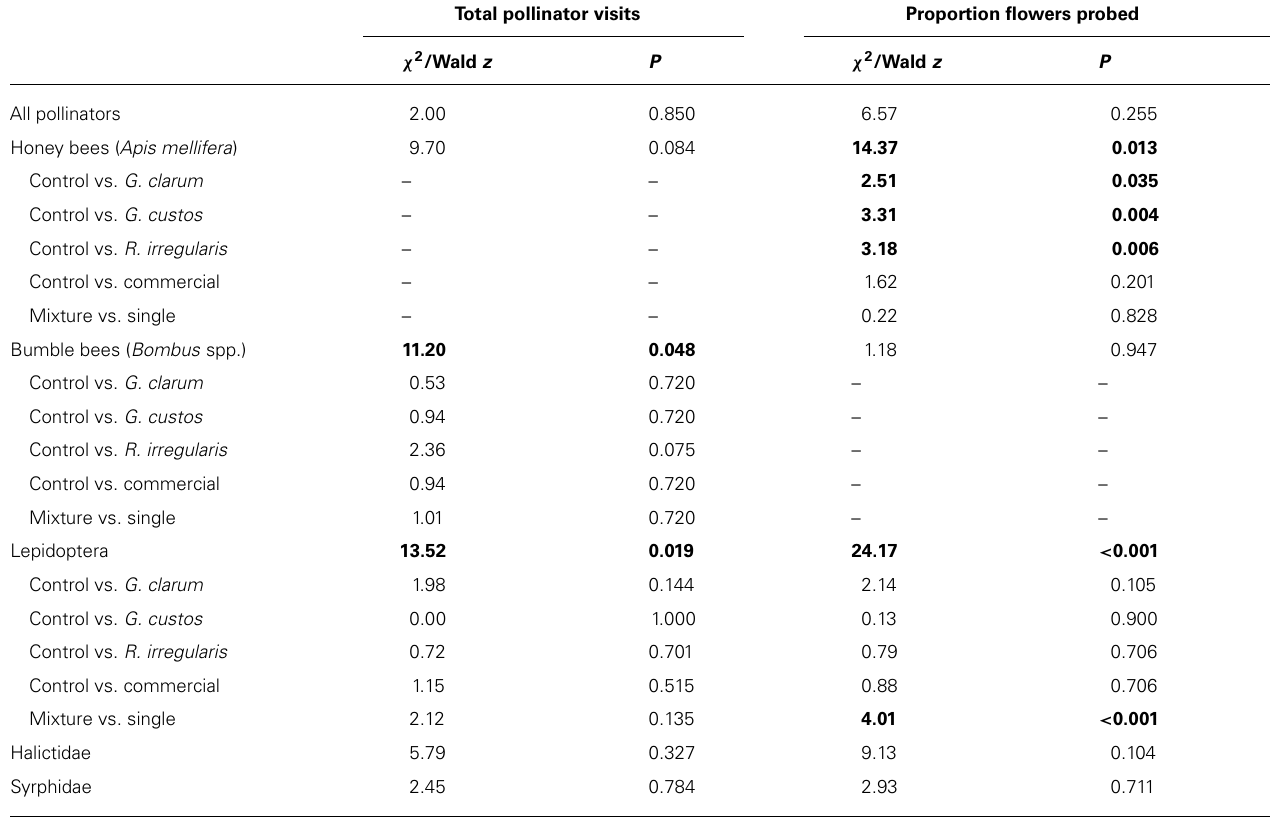
Table 3 | Results of GLMM analyses ofAMF treatment effects on total number of pollinator visits per plant and proportion of flowers probed, by pollinator